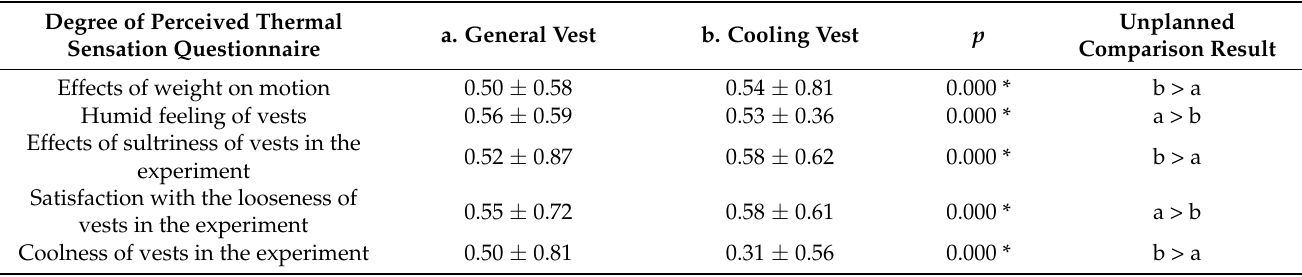
Table 6. Perceived thermal sensation (Likert-type scale; mean ± standard deviation; and unit: %). Degree of Perceived Thermal